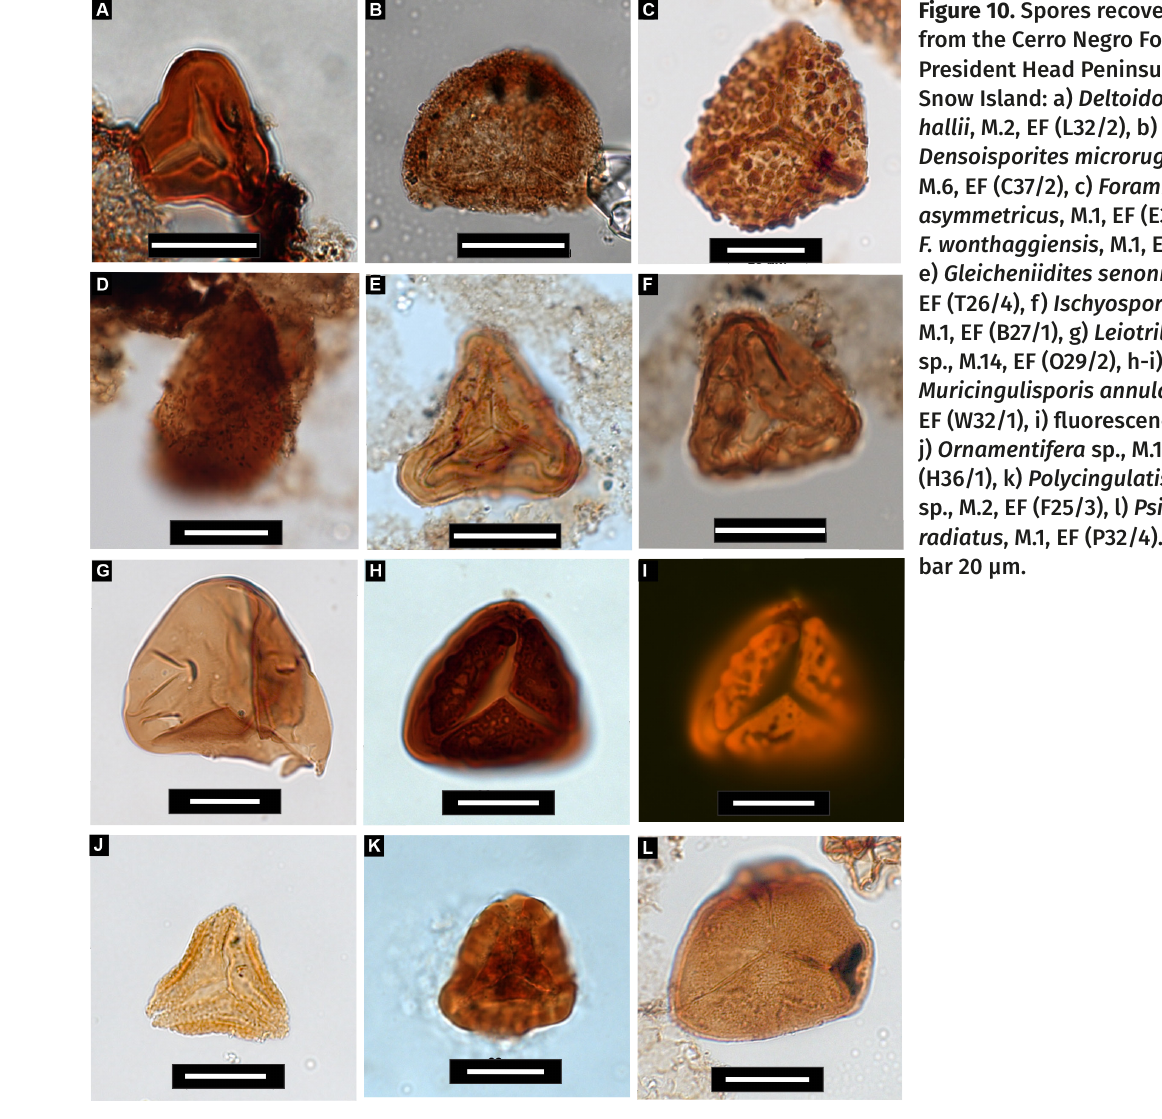
Figure 10. Spores